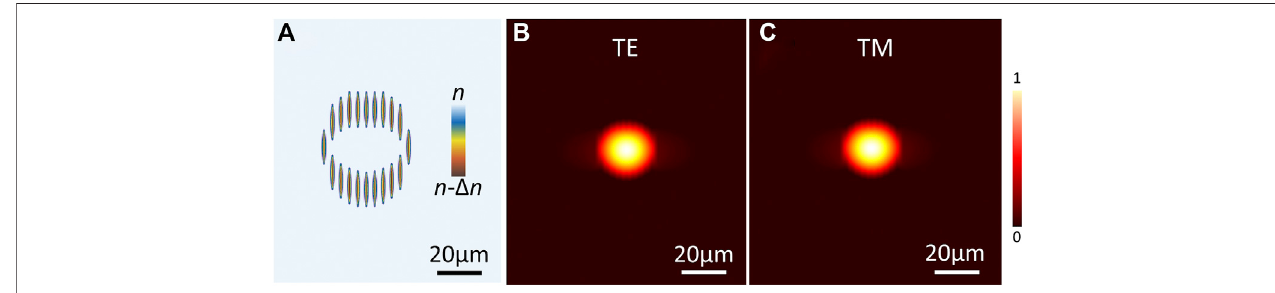
FIGURE 5 | (A) Re-constructure of refractive index distribution; (B,C) Simulated near- fi eld modal pro fi les of the reconstructed distribution at TE and TM polarizations,